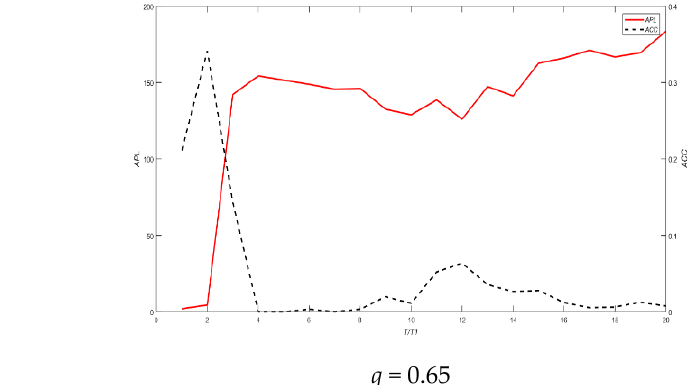
q = 0.15 q = 0.15 q = 0.15 Figure 10. Effect of changes in group initial knowledge richness q on APL and ACC. Figure 10. Effect of changes in group initial knowledge richness q on APL and ACC. Figure 10. Effect of changes in group initial knowledge richness q on APL and ACC. Figure 10. Effect of changes in group initial knowledge richness q on APL and ACC